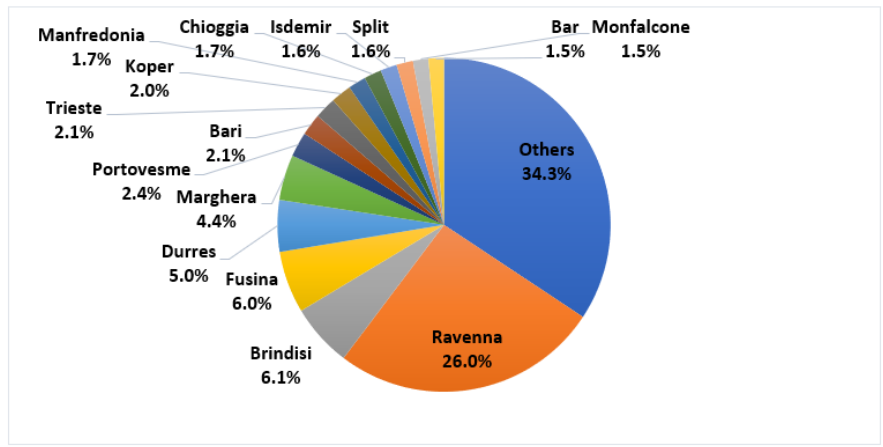
Figure 5. Percentages of BW discharged in the Port of Ploče by port of intake. Others (34.3%) include 128 donor ports or BW intake geographical positions. When